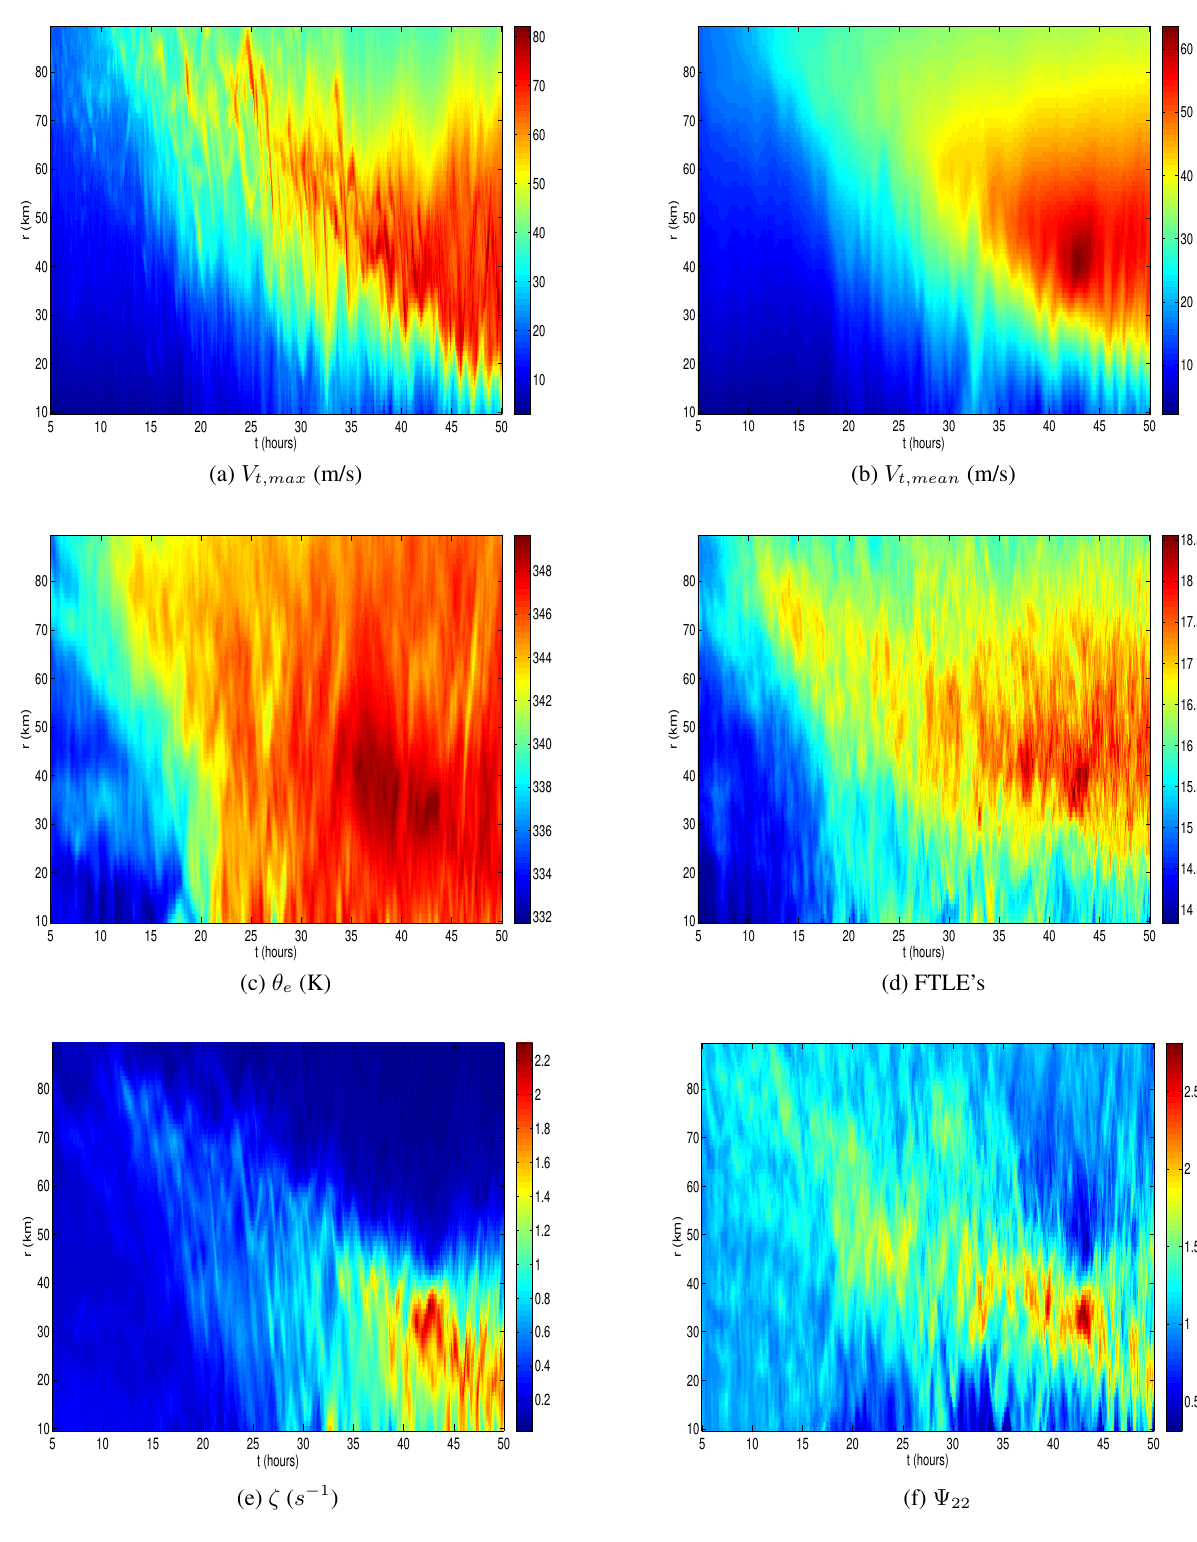
Fig. 2. Hovmoller plots (radial profile versus time) of azimuthally averaged V tan,max (a), V tan,mean (b), θ e (c), FTLE’s (d), ζ (e), and Ψ 22 (f). The V tan,mean , FTLE, Ψ 22 , θ e , and ζ values are averaged over the z=40 m horizontal plane, while V tan,max is a maximum over all heights and azimuths at each radius.